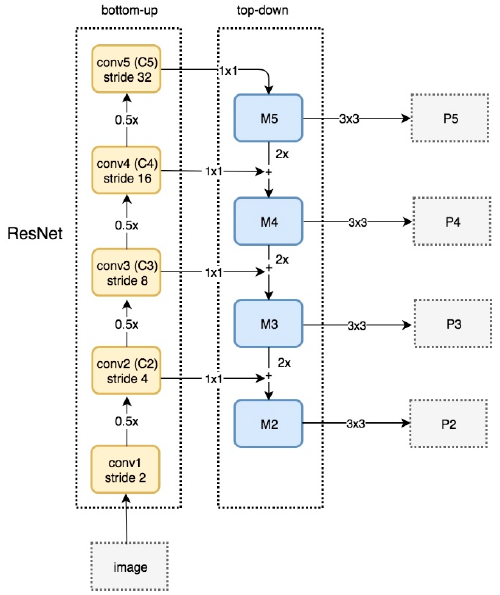
Figure 5. The connection between feature pyramid network (FPN) and ResNet50.